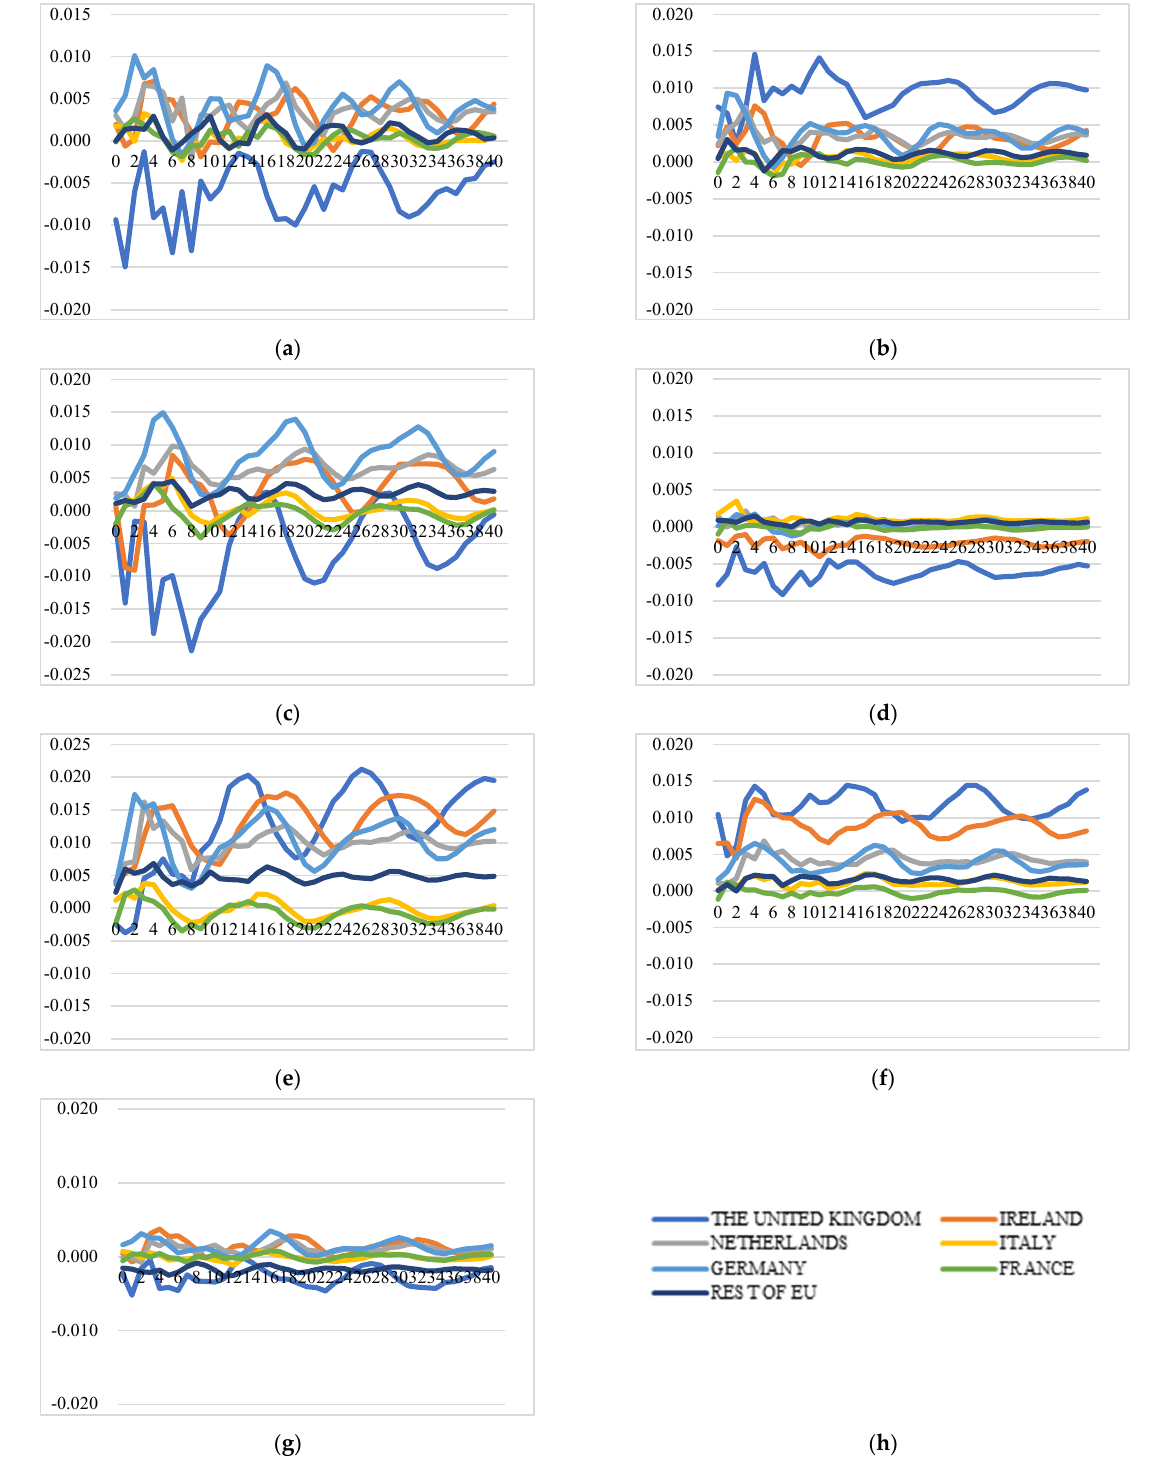
UK at similar levels to British extra-EU export prices.